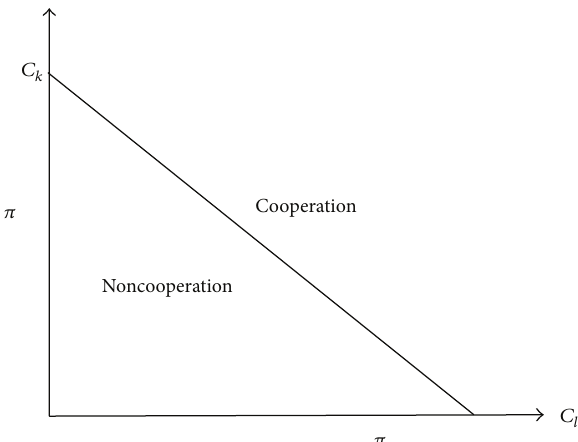
Figure 2: The choice of area of cooperation and noncooperation between the manager and the